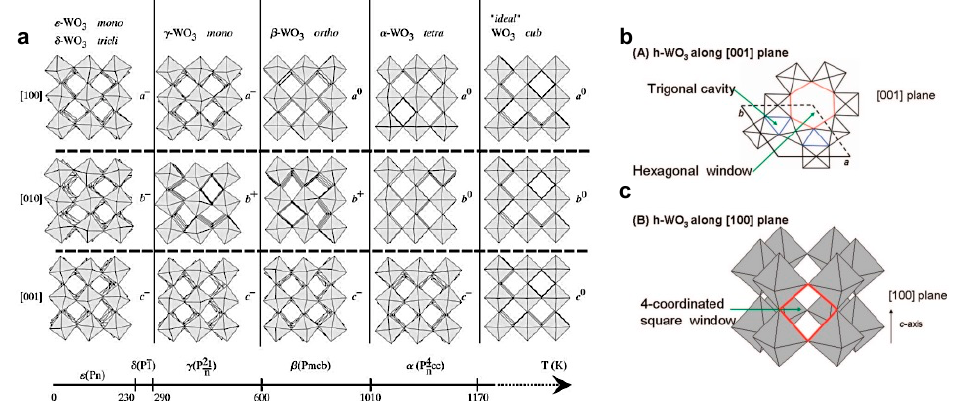
Figure 3. ( a ) Tilt patterns and stability temperature domains of the different polymorphs of WO 3 ; ( b ) the structure of h-WO 3 shown with the c -axis perpendicular and ( c ) parallel to the plane. Reproduced by [24].